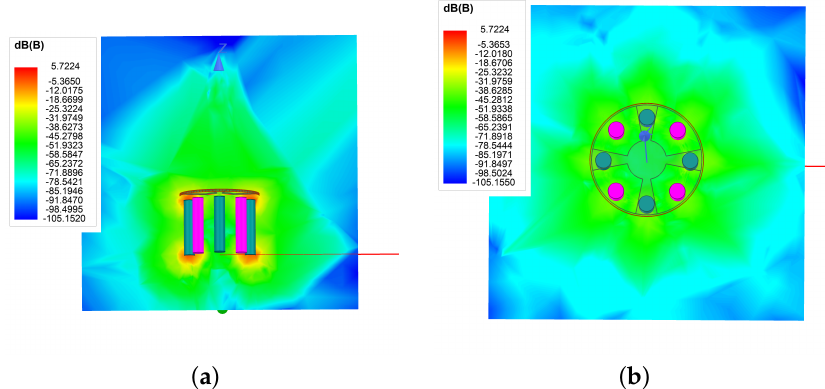
Figure 4. B-field distribution from different viewing angles: ( a ) side view; ( b ) top view.